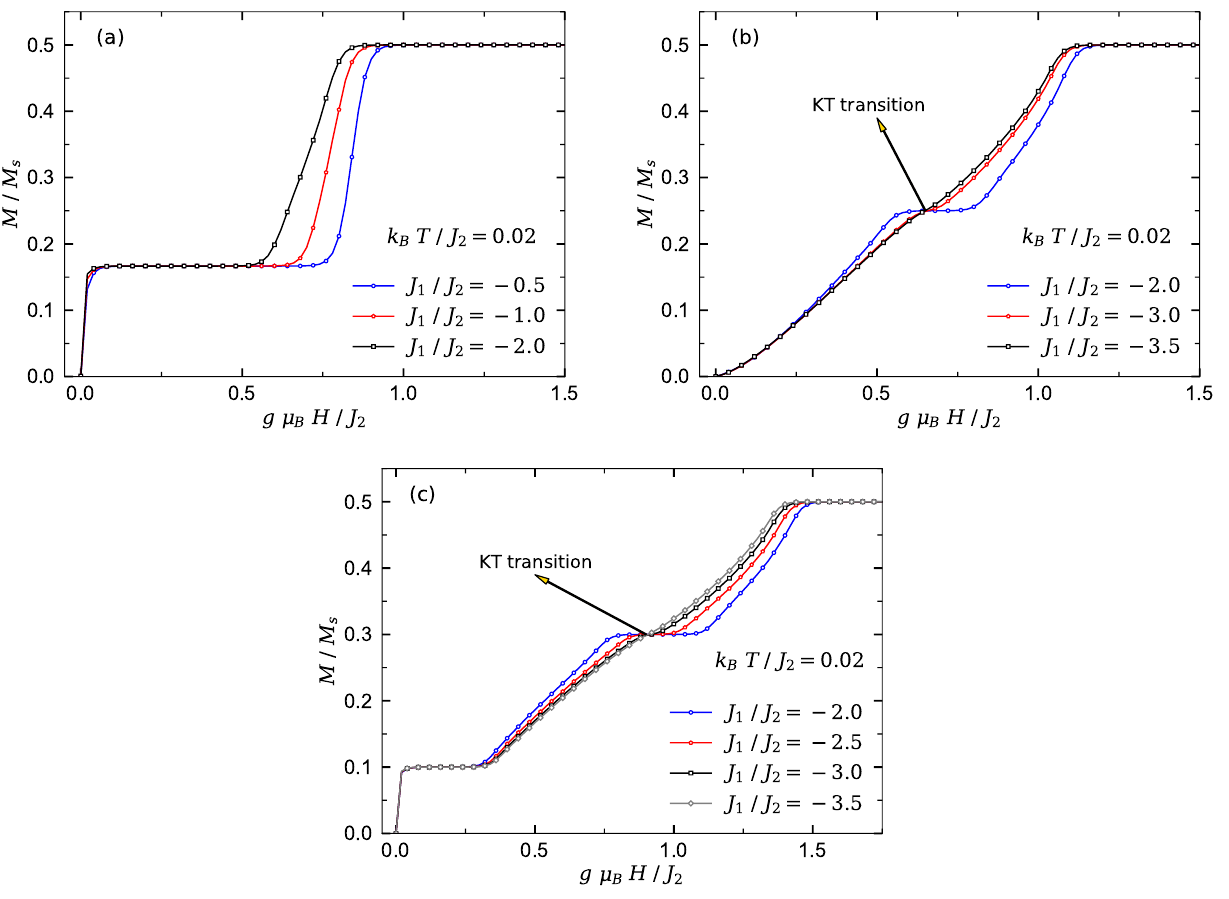
Figure 3. QMC results obtained for the magnetization curve of the three Heisenberg branched chains at low temperatures k B T / J 2 = 0.02 under the condition (II), assuming a few fixed values of the inter-chain interaction J 1 / J 2 . ( a ) Chain Υ 1 . ( b ) Chain Υ 2 . ( c ) Chain Υ 3